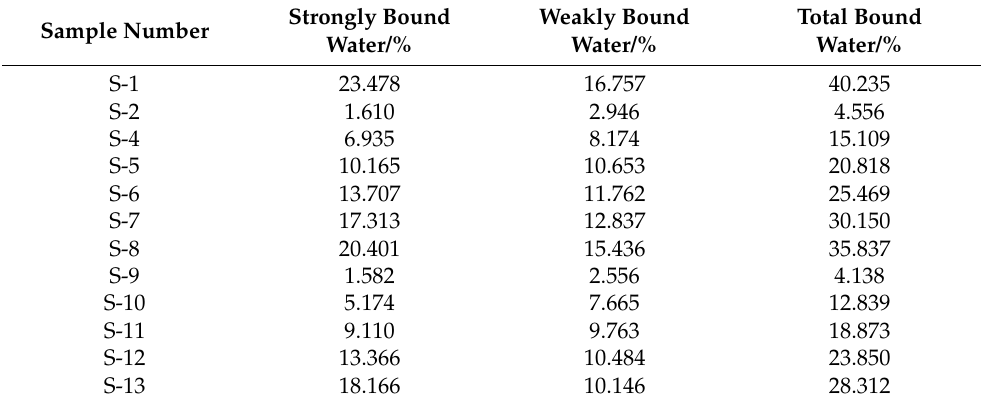
Table 5. Bound water of mixed clayey